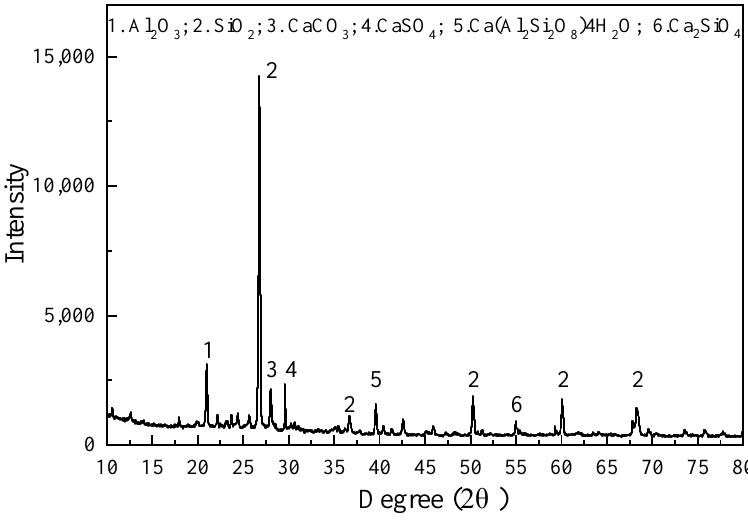
Figure 12. X-ray diffraction pattern of unreinforced sandy silt.